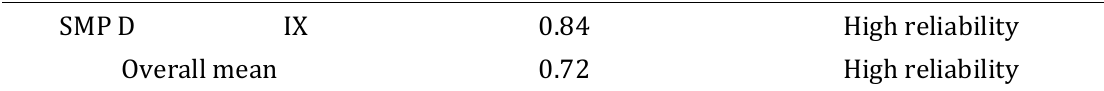
Table 3. Item Difficulty of the Test